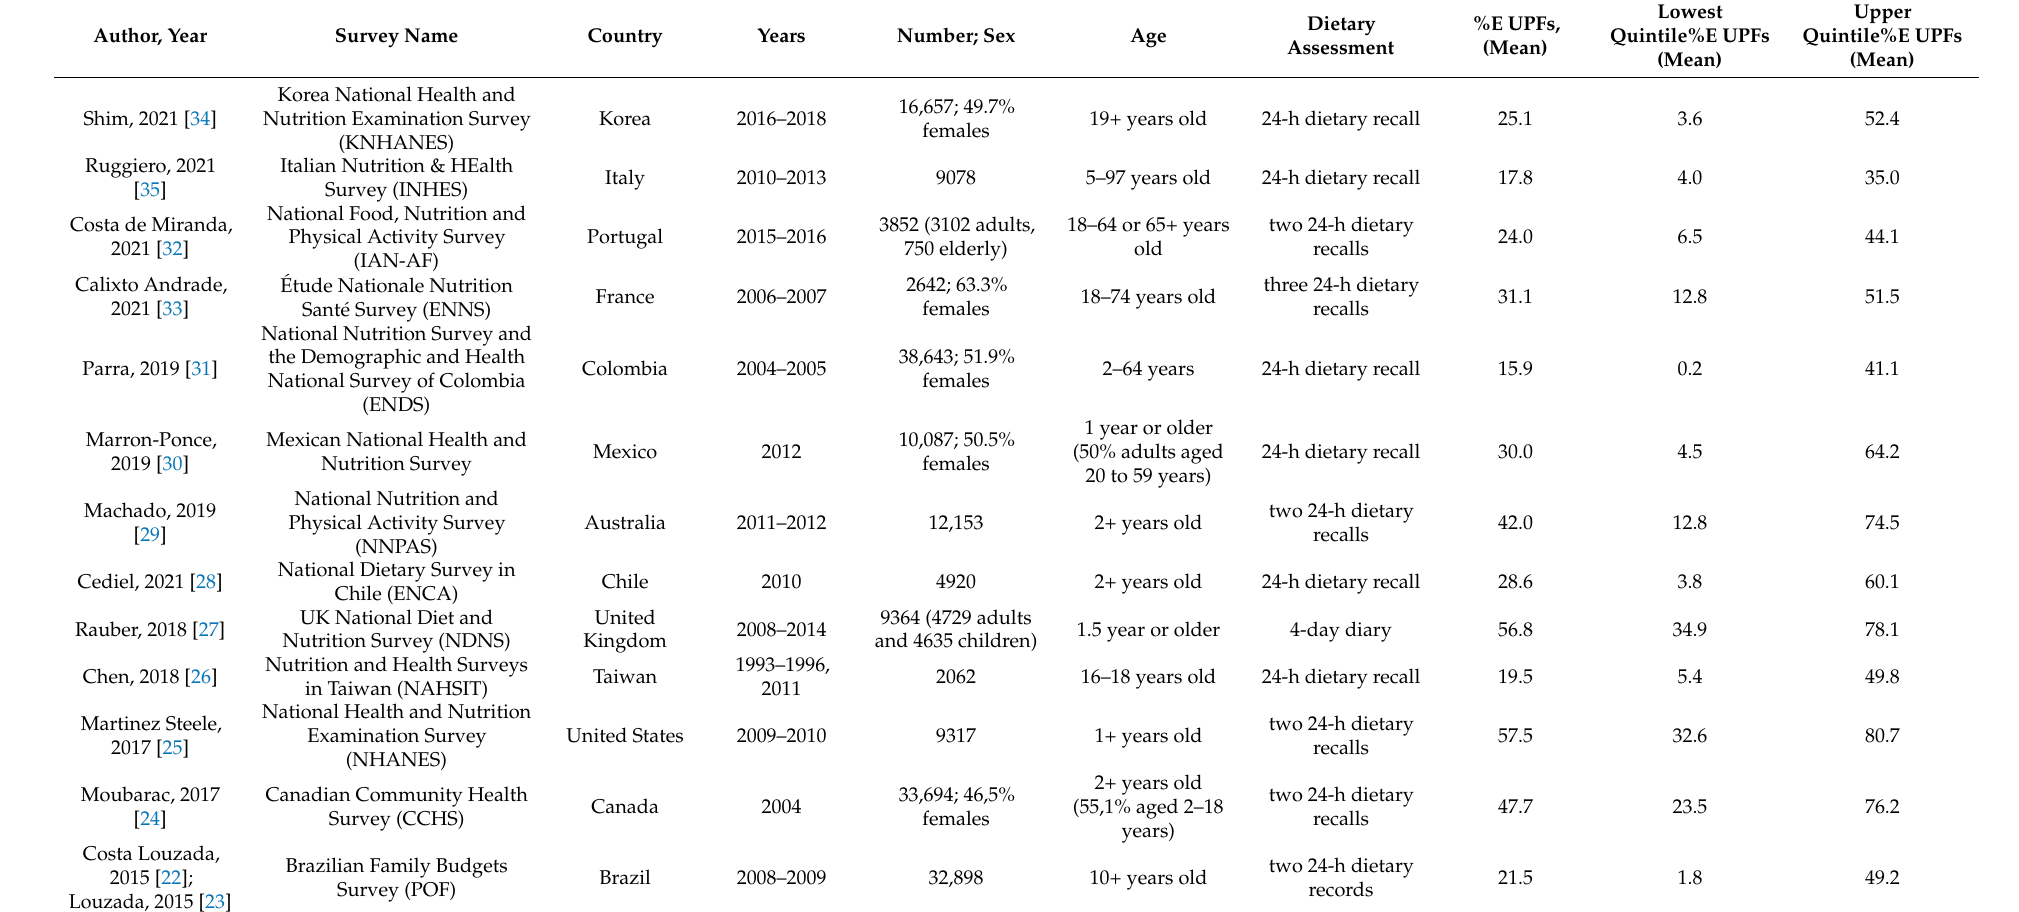
Table 1. Main characteristics of the nationally representative samples included in the